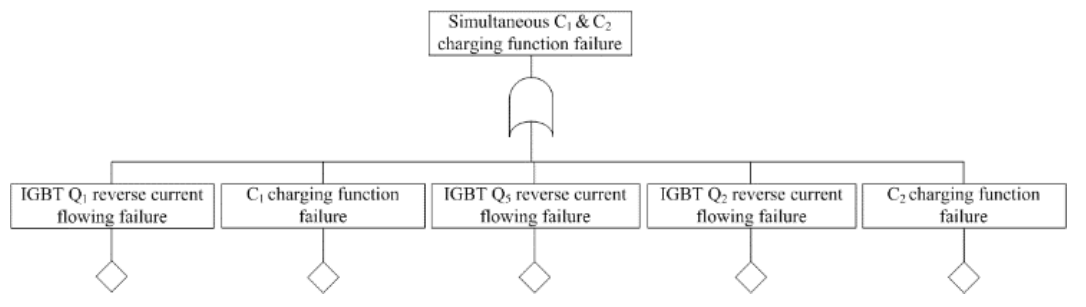
Figure 4. Sub fault tree for Simultaneous C 1 and C 2 charging function failure.